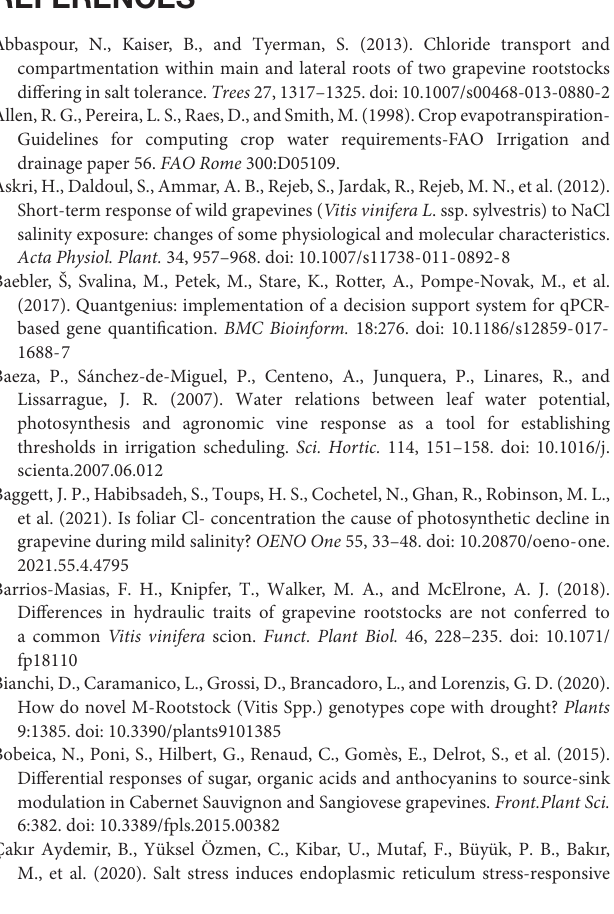
Supplementary Figure 3 | Log 2 FC values of genes involved in anthocyanin synthesis in Tempranillo in salinity-treatment leaves as compared to controls grafted onto 1103-Paulsen, M1, and M4. The specific gene names are provided by means of the Vitvi identifiers. Color represents the value of Log 2 FC. PAL,